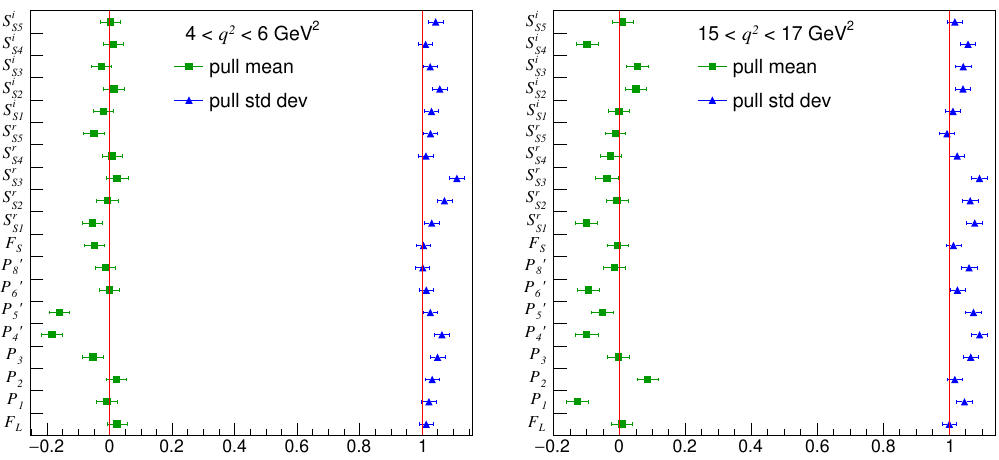
Figure 9 . Summaries of the (green) means and (blue) standard deviations of the pull distribution for the optimised P-wave observables and normal interference observables in two bins of q 2 . The red lines are references at 0 and